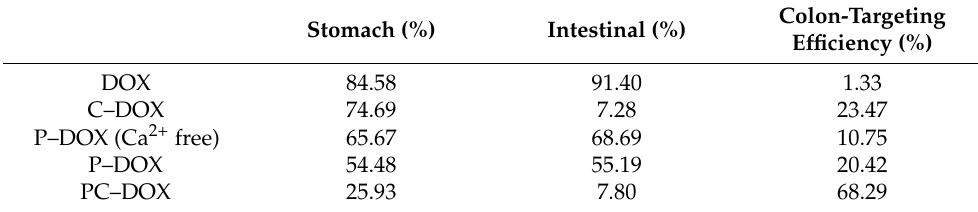
Figure 2. ( A ) Schematic diagram of the oral administration of PC − DOX; ( B ) the diagram of simulat- ing drug release in the stomach (pH 1.2) ****p<0.0001( n =3); ( C ) the diagram of simulating drug re- lease in the intestine (pH 6.8) ****p<0.0001( n =3). Table 1. The table of colon-targeting efficiency. Table 1. The table of colon-targeting